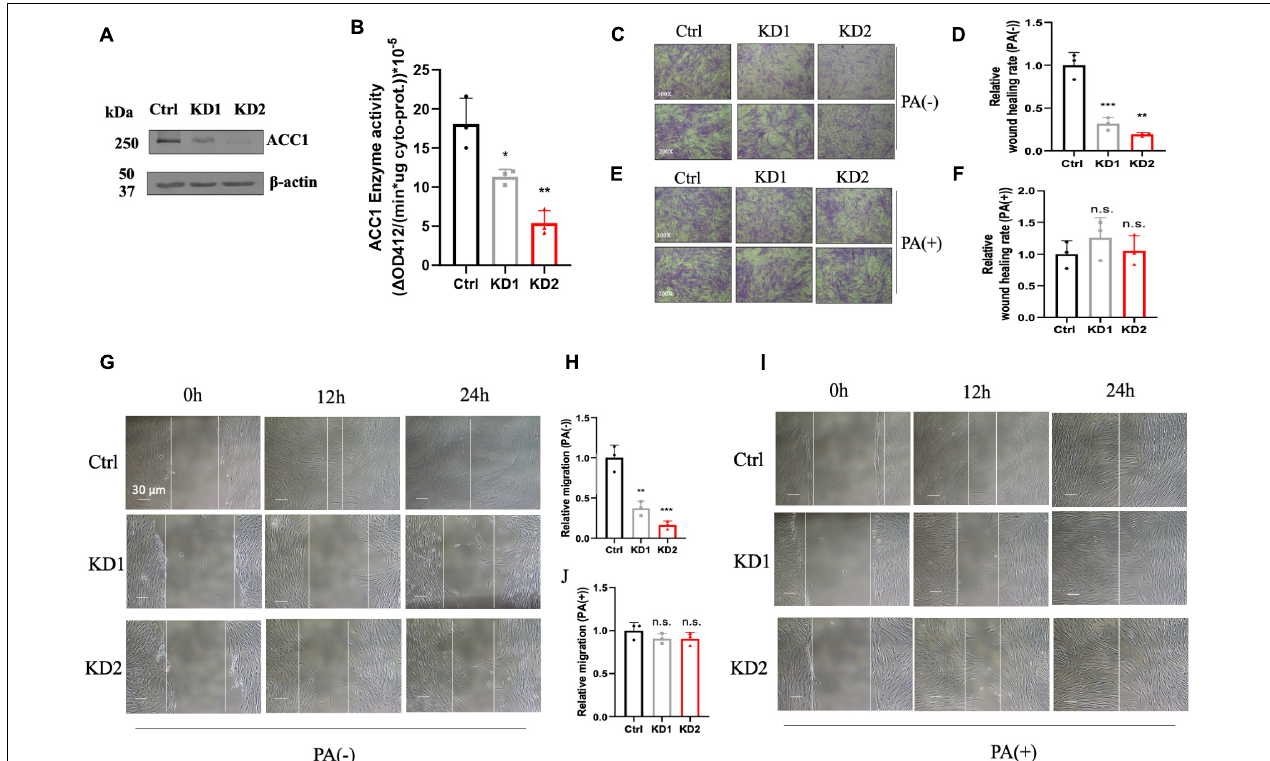
FIGURE 4 | ACC1-knockdown (KD) fibroblasts and the cell motility capacity measurement. (A) The ACC1 protein content of ACC1-KD fibroblast cell lines, and (B) the ACC1 enzyme activity. The wound healing assay was carried out at different time points (0, 12, and 24 h) (C) without or (E) with palmitate (scale bar = 30 µ m), and (D,F) show quantitative analysis, respectively. The Trans-well migration capacity at 100 × magnification (upper) and 200 × magnification (lower) (G) with or (I) without palmitate, respectively. (H,J) The quantitative analyses, respectively. All data were from three independent replicates and analyzed by mean ± SEM. Independent t -test in panels (A,B,D,F,H,J) . * p < 0.05, ** p < 0.01, *** p <